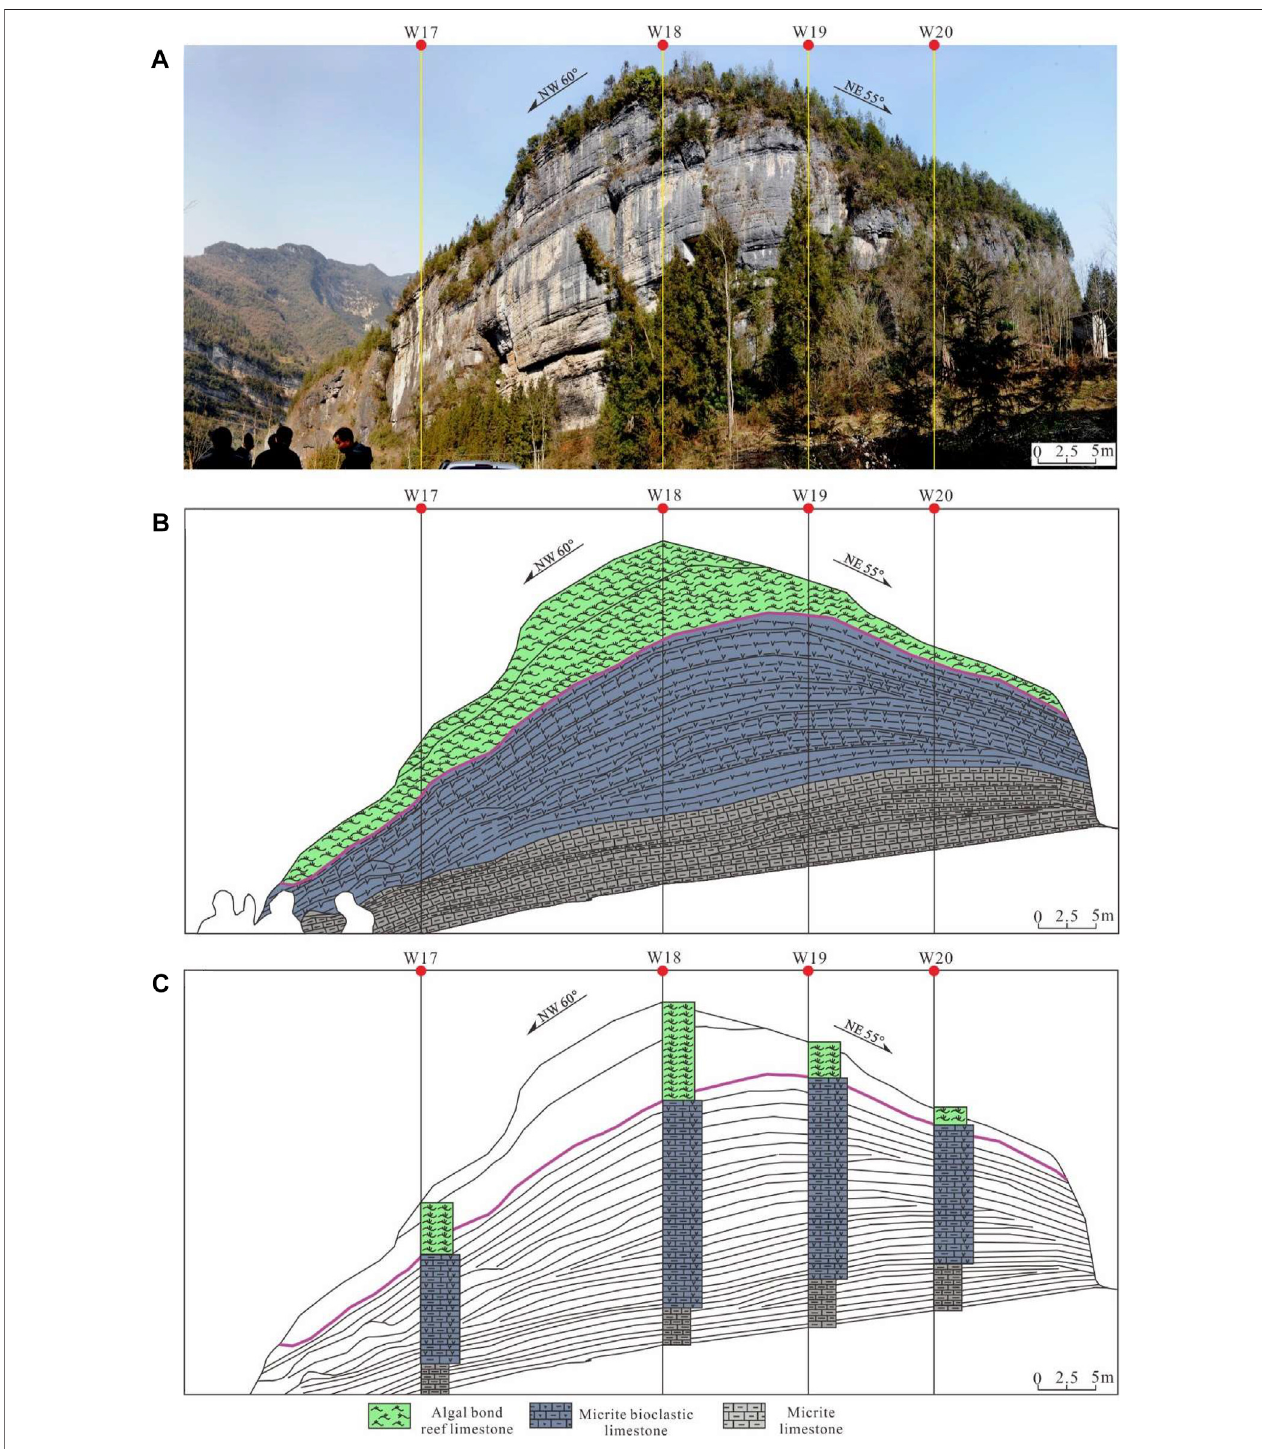
FIGURE 7 | Architecture geological model of Jiantianba CC ’ section, Lichuan. (A) Field outcrop picture; (B) outcrop pro fi le sketch; (C) architecture geological model.